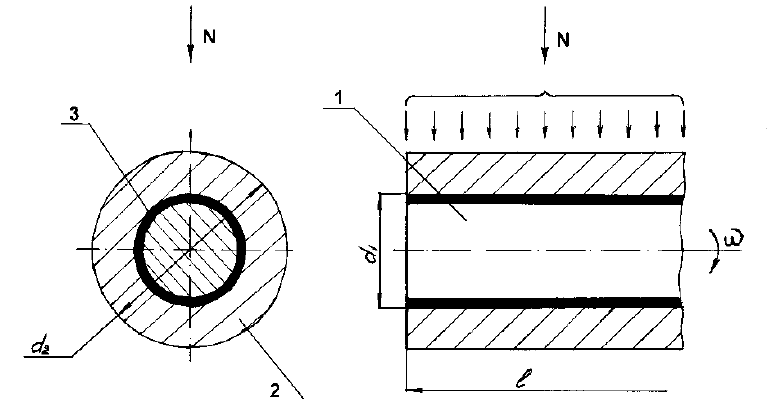
Fig. 3. Scheme of contact tribocoupling of parts with a polymer coating: 1 - shaft; 2 - sleeve; 3 – polymer